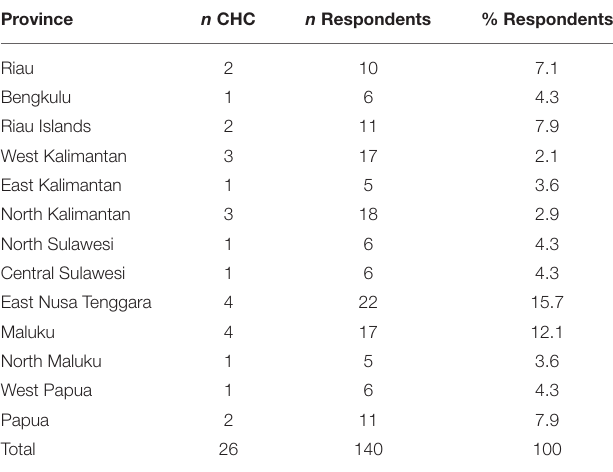
TABLE 1 | Number of community health centers and respondents by